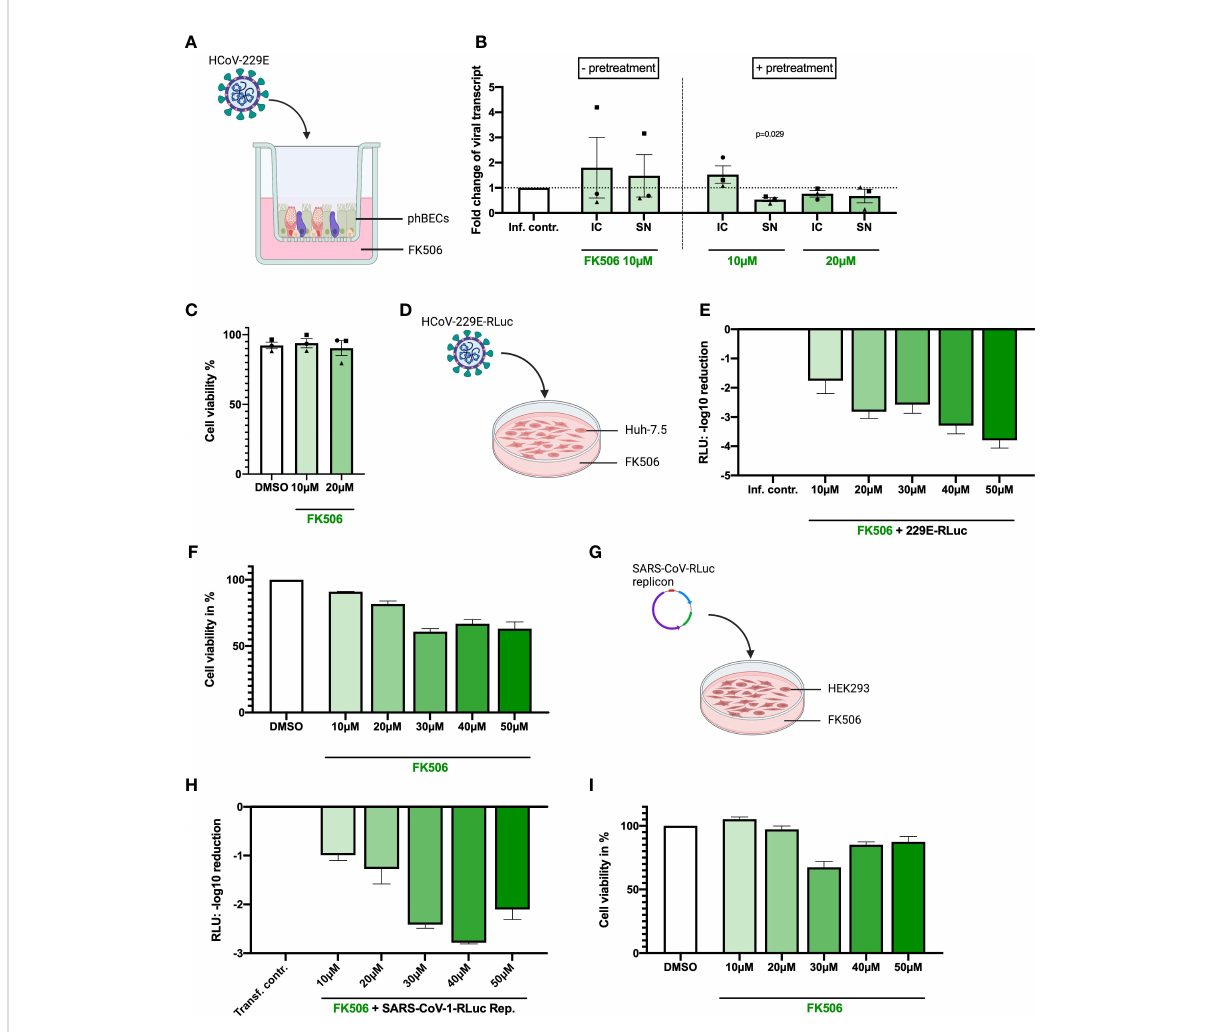
FIGURE 3 Inhibitory effects of FK506 in different human infection models. (A) Illustration of phBEC infection with HCoV-229E, created with biorender.com. (B) RT-qPCR results of (for 72 h) HCoV-229E infected (MOI = 4) phBECs (n = 3, independent donors) with and without pretreatment in presence of compound FK506, given as fold changes of intracellular (IC) and supernatant (SN) viral transcript relative to the infection control (inf. contr.), HCoV-229E-infected phBECs treated with the vehicle DMSO (normalized to 1 for both IC and SN). Intracellular: Normalized to the housekeeping gene DEAH-Box Helicase 8 ( DHX8 ). The symbols each represent an independent donor (circles = donor 1; squares = donor 2; triangles = donor 3). For statistical analysis a paired two-tailed t-test was used and absolute p -values are given for p < 0.05. (C) Cell viability was assessed by LDH assay after drug treatment for 48 h pretreatment followed by 72 h post infection in percent. Both mock-infected and coronavirus-infected cells had been pretreated with 10 µM inhibitor in medium for 48 h until infection. Following infection the basolateral medium was fully removed and fresh medium with the same inhibitor concentration (i.e., 10 µM) added, keeping the concentration constant at any given timepoint. (D) Illustration of Huh-7.5 infected with a variant of HCoV-229E expressing Renilla luciferase. Figure was created with biorender.com. (E) HCoV-229E infection of Huh-7.5 cells for 48h: Renilla luminescence was quanti fi ed as a measure of viral replication. The results are shown in log scale (log 10 reduction). (F) Cell viability of Huh-7.5 cells was measured after 48 h of inhibitor treatment using the Celltiter-Glo assay and is shown in percent. (G) Illustration of transfection of HEK293 cells with a pBAC-SARS-Rep-Rluc plasmid expressing Renilla luciferase. Figure was created with biorender.com. (H) pBAC-SARS-Rep-Rluc transfection into HEK293 cells for 48 h: Renilla luminescence was quanti fi ed as a measure of viral replication. The results are shown in log scale (log 10 reduction). (I) Cell viability of HEK293 cells was measured after 48 h of inhibitor treatment with the Celltiter-Glo assay. All results are shown as mean ±